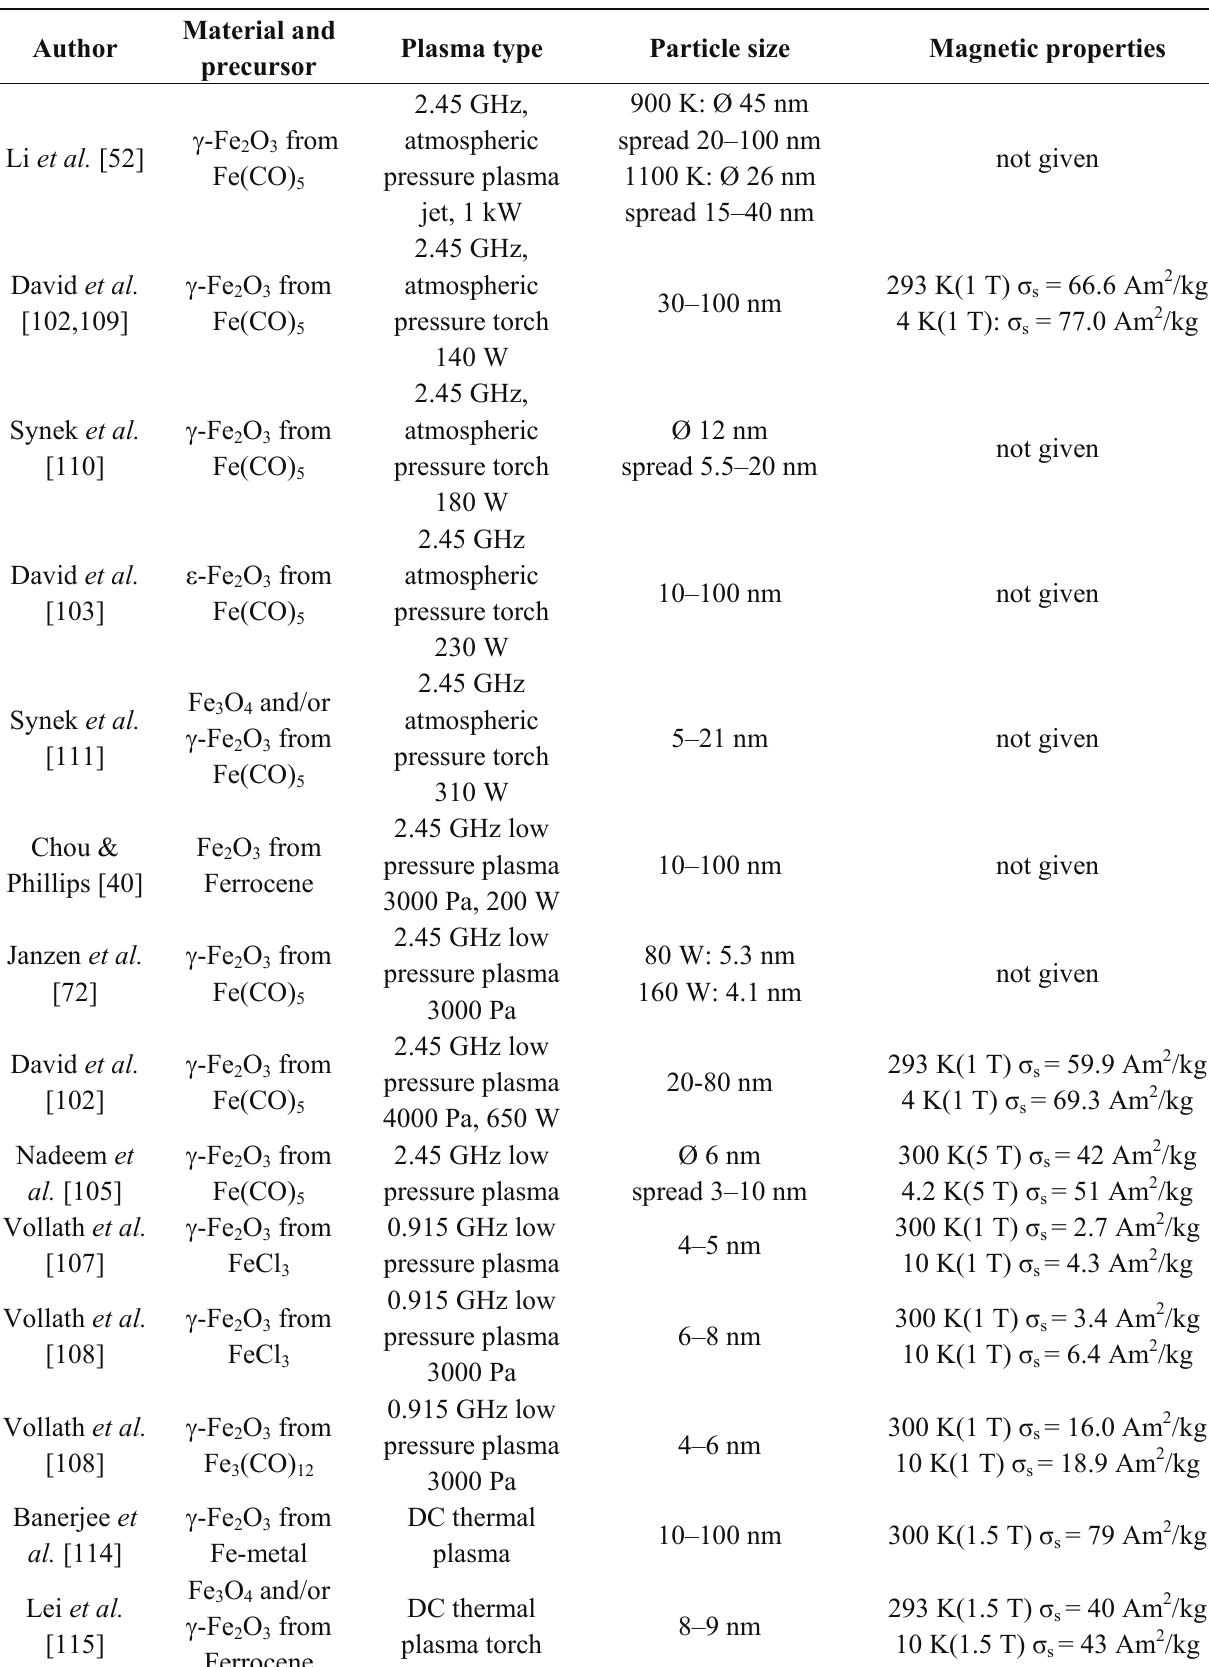
Table 7. Fe O nanoparticles and the relevant properties particle size and 2 3